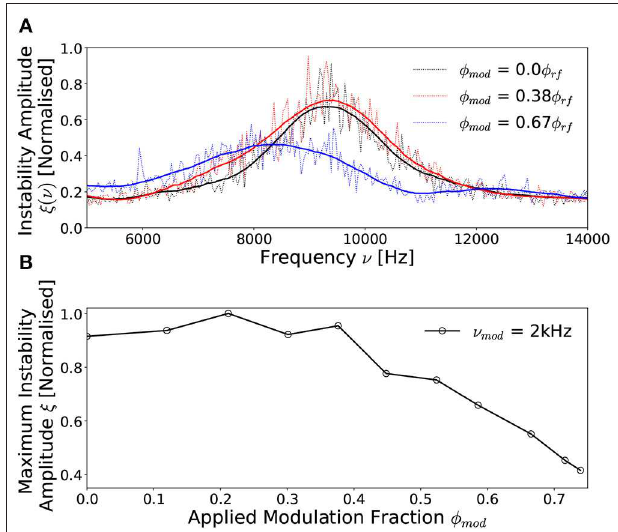
FIGURE 7 | Normalized instability amplitude profiles as measured at the beam-conic interface downstream of the DL (R, Z = –6 cm, 2 cm) with a ν mod = 2 kHz voltage amplitude modulation for (A) φ mod = 0.0 φ rf , φ mod = 0.38 φ rf and φ mod = 0.67 φ rf and (B) the variation in peak instability amplitude with respect to increasing φ mod . Solid lines in (A) were smoothed employing a SavitzkyGolay filter and included in (B) to guide the eye. Operating conditions: helicon antenna supplied P rf = 300 W at ν rf = 13.56 MHz employing 0.42 mTorr argon with I 1,2 = 6 A solenoid